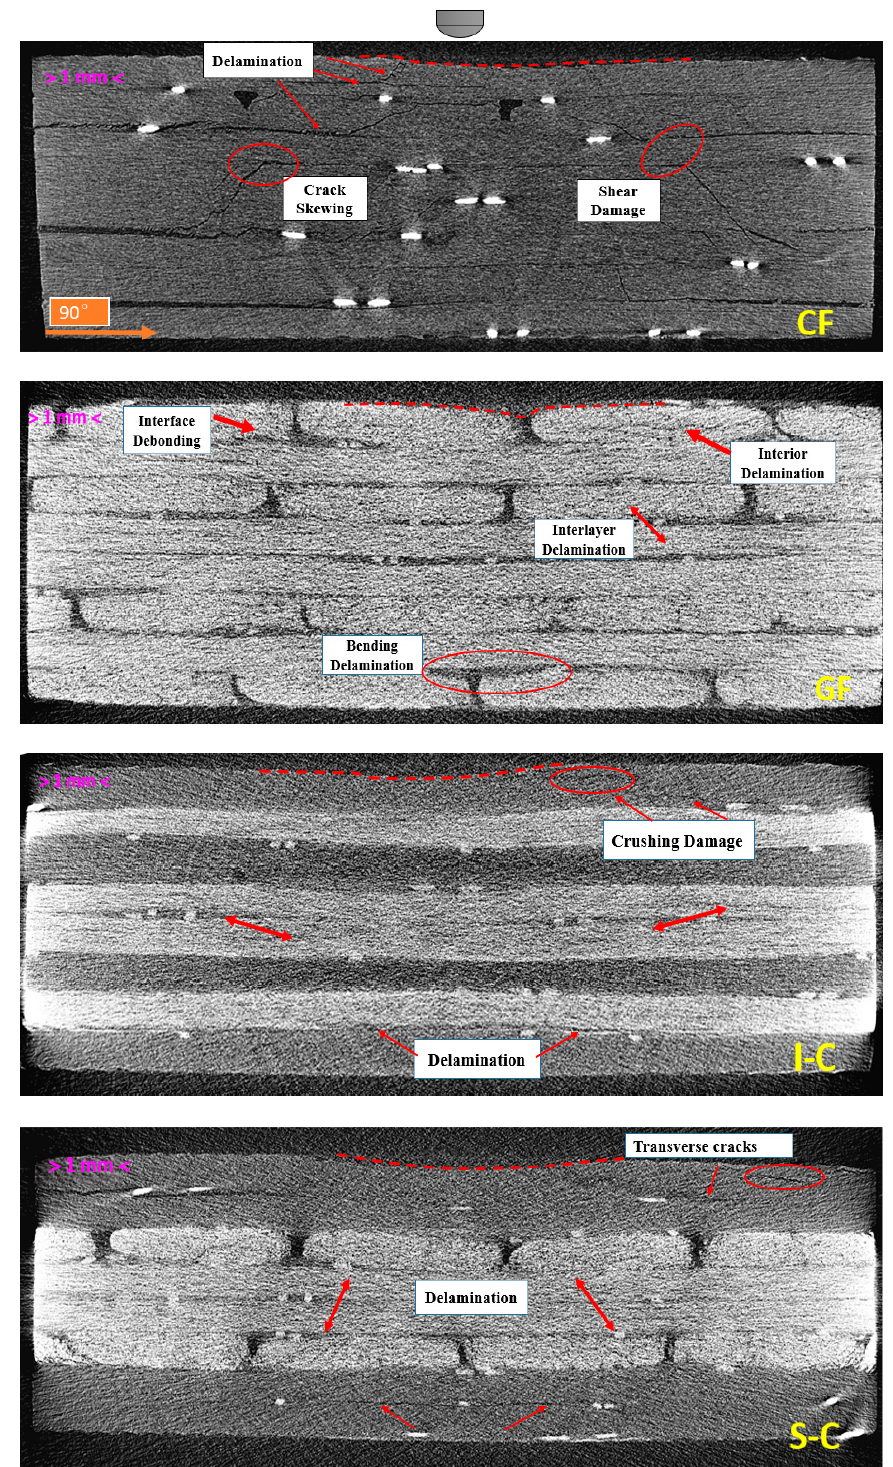
Figure 7. Representative CT scans (0° slices) of the CF, GF, I-C, and S-C specimens after a 30 J impact.